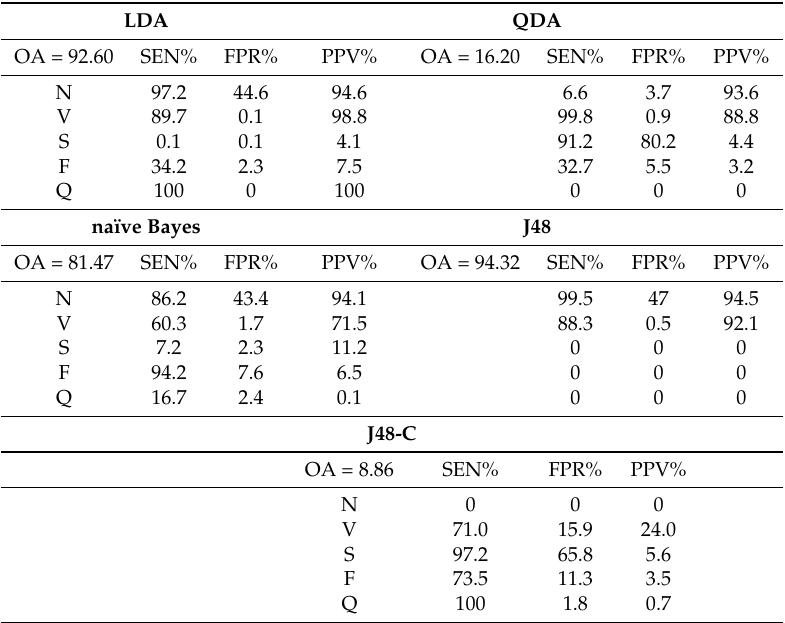
Table 7. Performance measures for LDA, QDA, naïve Bayes, J48 and J48-C classifiers. LDA QDA OA = 92.60